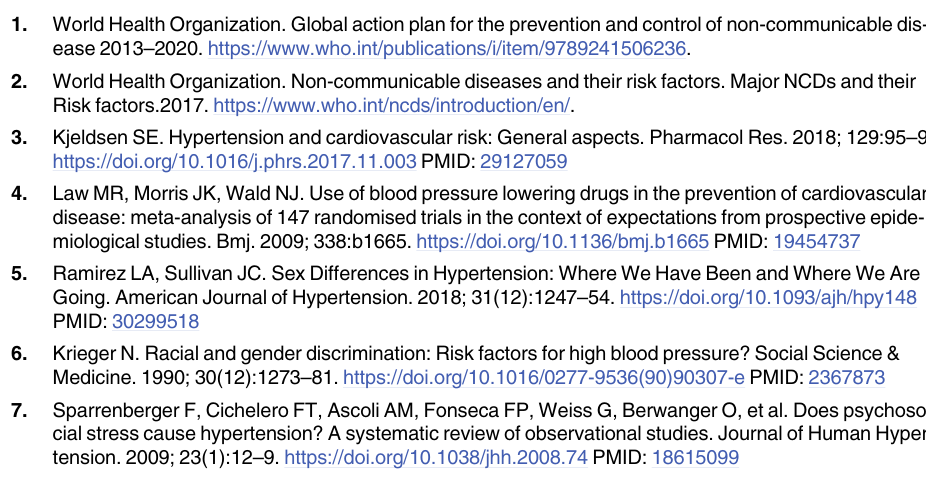
S5 Table. Estimated salt intake by survey language category. Estimated Salt Intake per day (g) by Survey